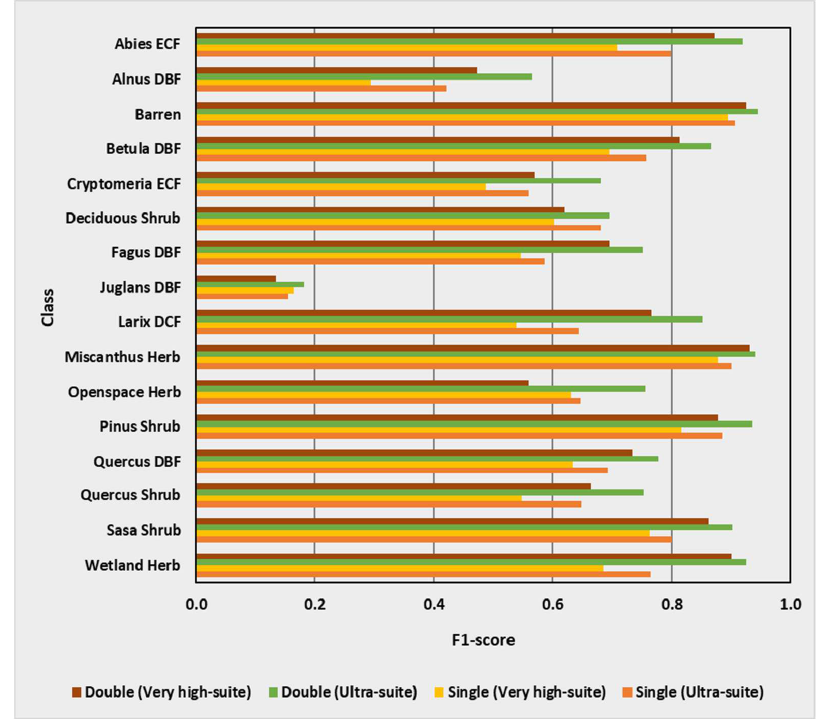
Figure 12. Class-wise changes in accuracy (F1-score) by addition of summer images in the Hakkoda site.